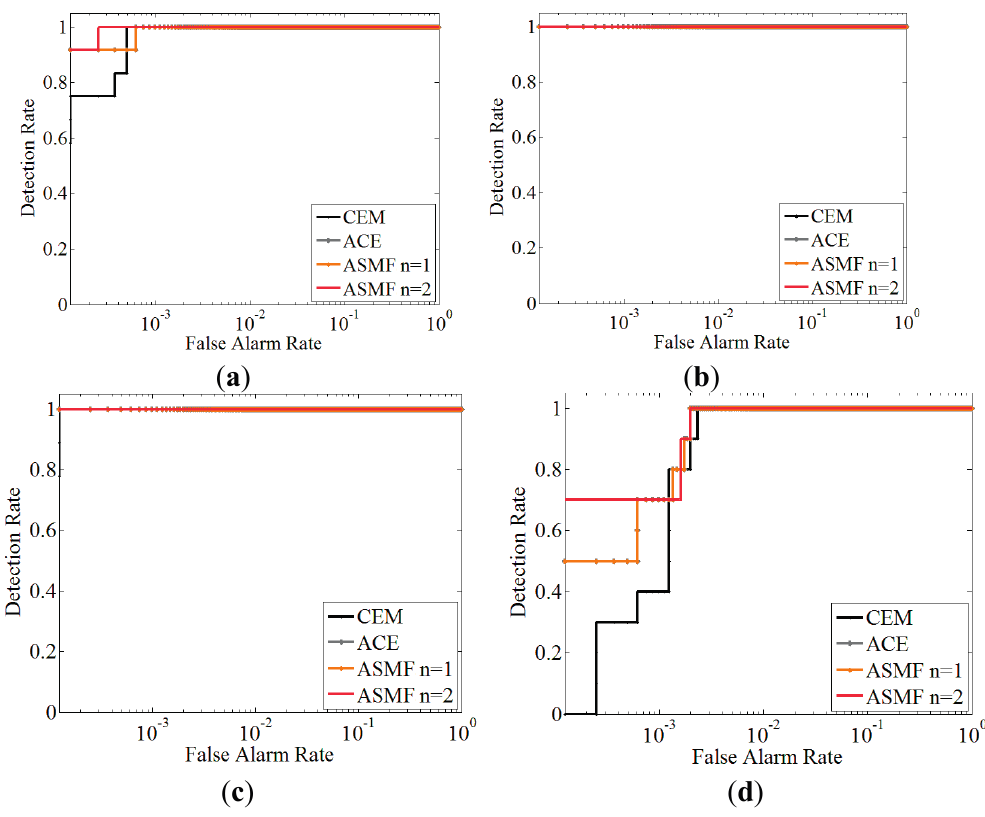
Figure 15. Locations and detection results obtained by the compared algorithms of ( a ) F1, ( b ) F2, ( c ) F3, and ( d ) F4, where results of CEM, ACE, ASMF with n = 1, and ASMF with n = 2 are shown from left to right in each row.